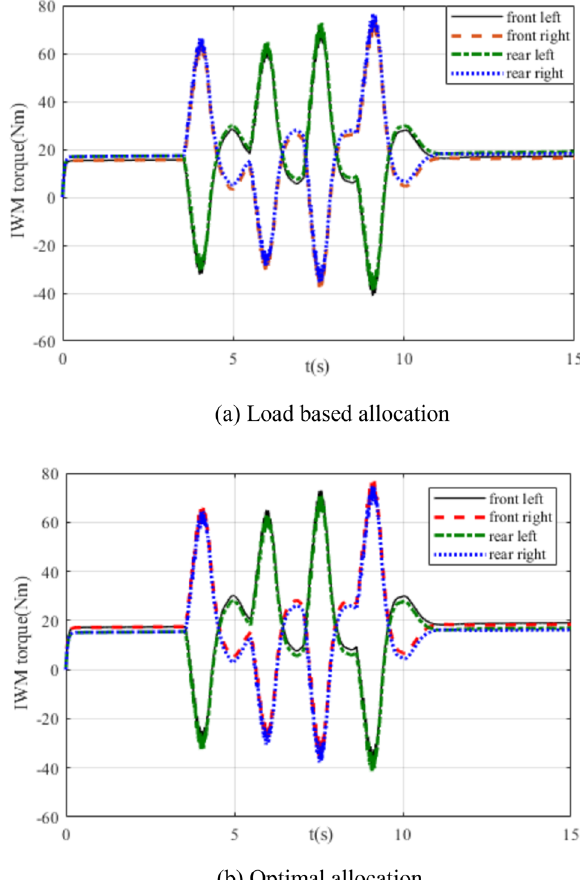
Figure 8 Simulation results of IWM torques